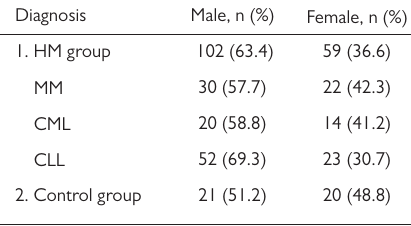
Table 1. Gender Distribution of Patients with HM and Control